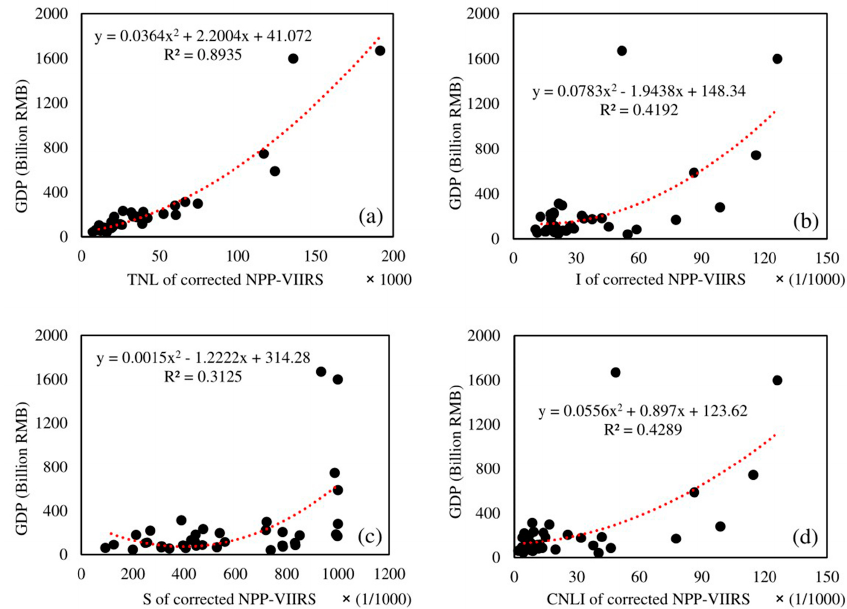
Figure 6. Statistical relationships between GDP and four light indices for corrected VIIRS data at the prefecture level: ( a ) the total nighttime light (TNL); ( b ) average nighttime light intensity (I); ( c ) proportion of intensely lit area (S); and ( d ) compounded nighttime light index (CNLI).